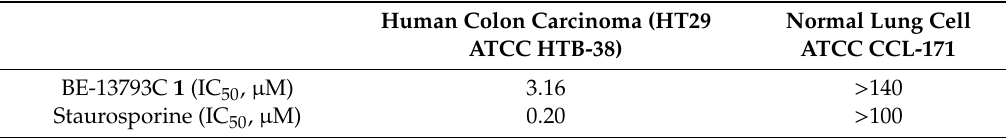
Table 4. Antiproliferative / cytotoxic activities of 1 .